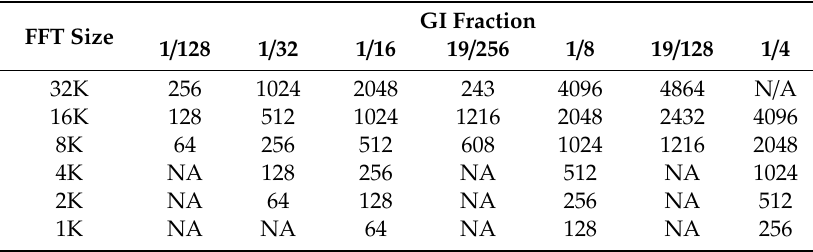
Table 2. DVB-T2, DVB-C2, and DVB-S2 features.